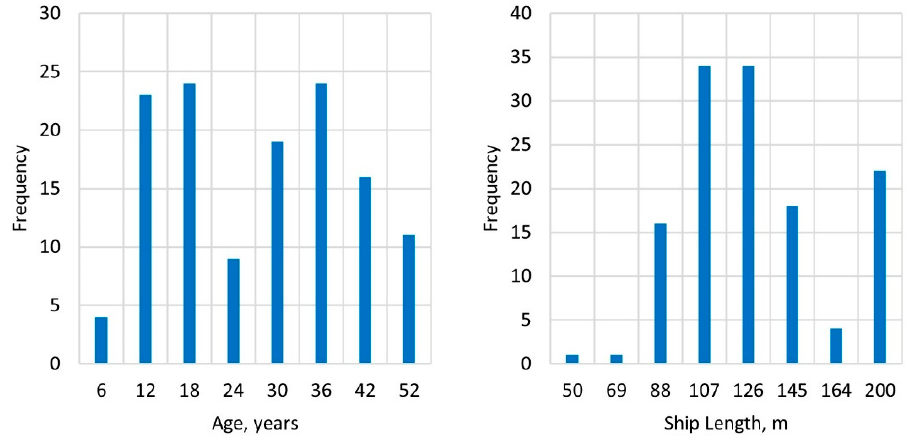
Figure 3. Age ( left ) and length ( right ) of queuing ships.